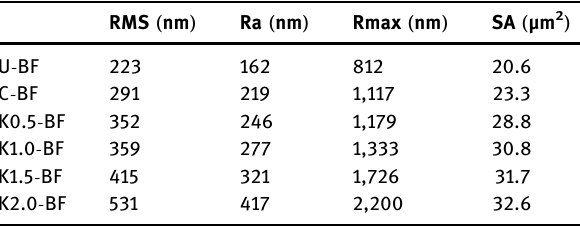
Table 3: Surface roughness parameters of BFs RMS ( nm